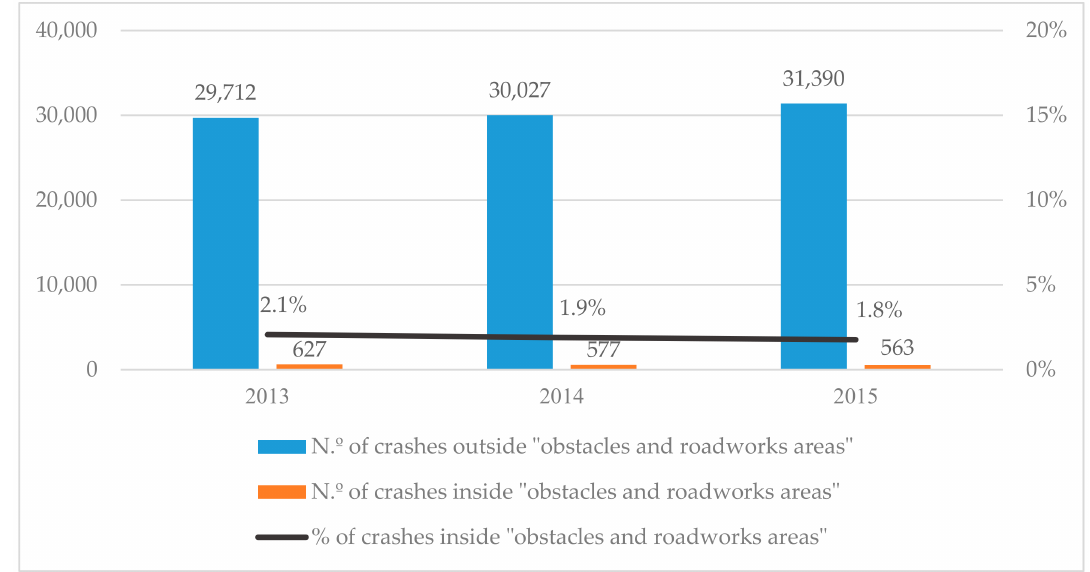
Figure 1. Evolution of the number of crashes in Portuguese road work